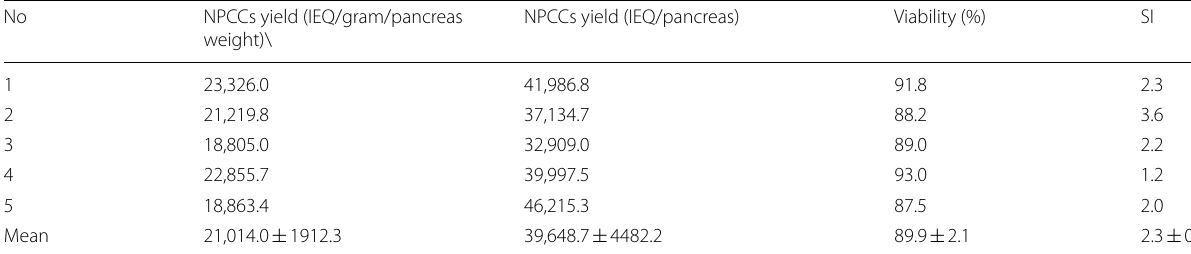
Table 1 The yields, viability and functionality of NPCCs at 5 days after isolation No NPCCs yield (IEQ/gram/pancreas NPCCs yield weight)\